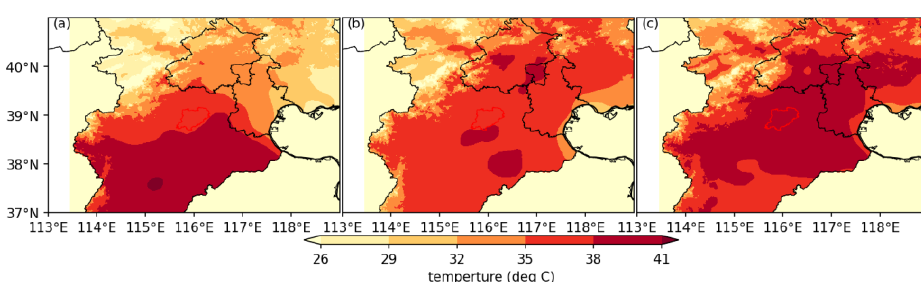
Figure 2. Distribution of maximum temperature on ( a ) 2 July, ( b ) 3 July and ( c ) 4 July.